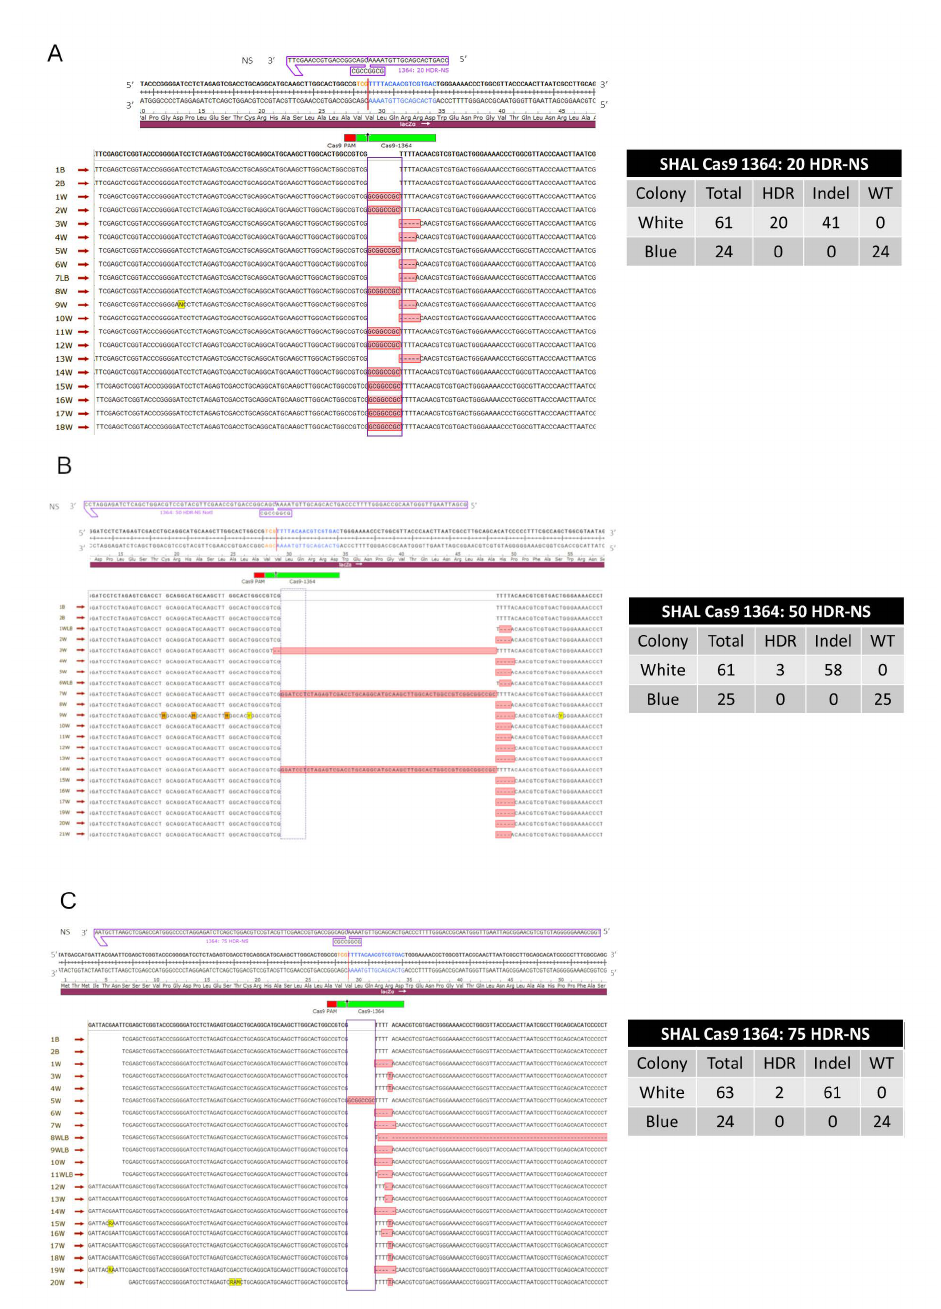
Figure 4. ( A – C ) Symmetrical homology arm lengths using CRISPR / Cas9. Each image illustrates the location of Cas9 in green and the PAM site in red. A solid red line indicates the blunt ended cleavage site. ( A – C ) symmetrical homology arm lengths of 20, 50, and 75 base pairs (48, 108, and 158 bases total). The nonsense symmetrical oligonucleotide with lengths of 20, 50, or 75 base pairs on either side of the cut site is located above the lacZ gene, contains an eight base NOTI site in the center, and is positioned in a 3 (cid:48) –5 (cid:48) orientation. The purple box highlights the correct integration of a NOTI site and bases highlighted in red outside of the purple box indicate unintended integration or deletion events for each image. The table to the right of the images illustrates the total number of blue and white colonies sequenced and if they were found to harbor homology-directed repair, insertions or deletions (Indels), or a wild-type event. All blue colonies were found to harbor wild-type sequences represented by the two blue colonies (labeled 1B and 2B) in all images. All experiments were conducted in triplicate and the combined data is shown only in the tables present. The remaining sequencing data is shown in Figure S2 and the individual colony numbers for each trial are shown in Table